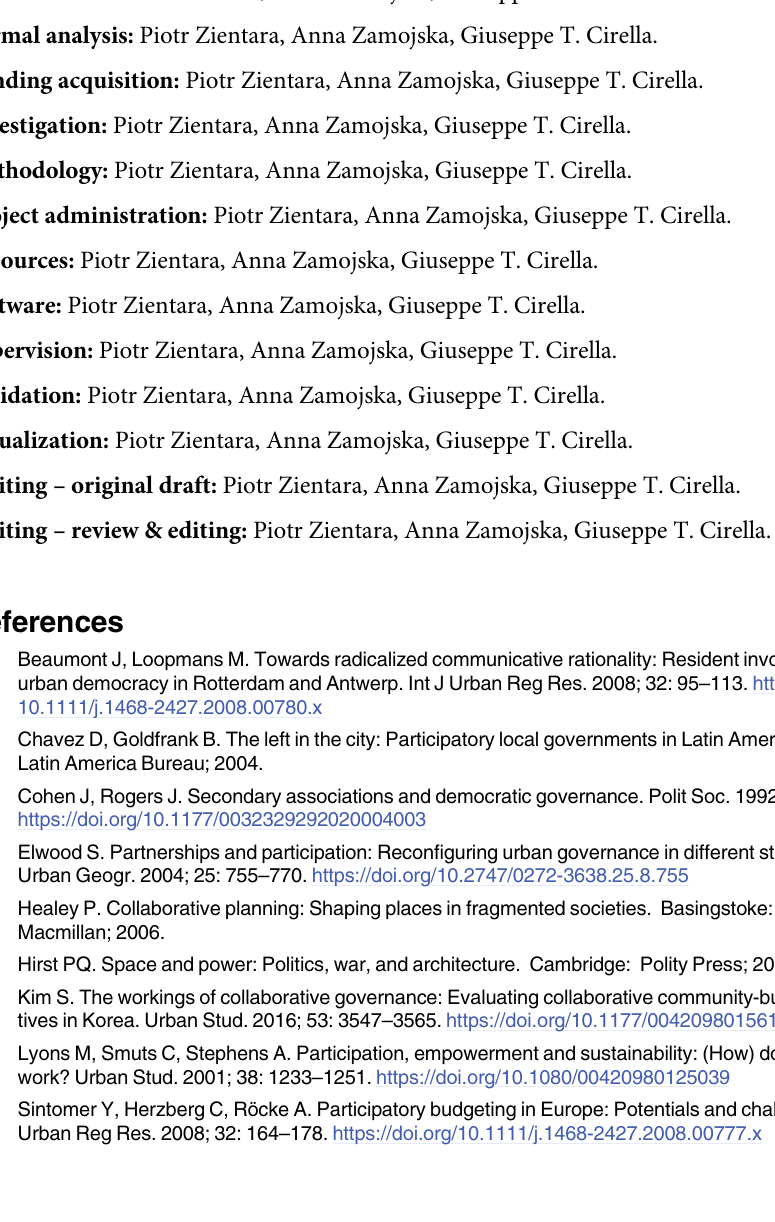
S1 Table. Relative frequencies for controls of the groups of residents